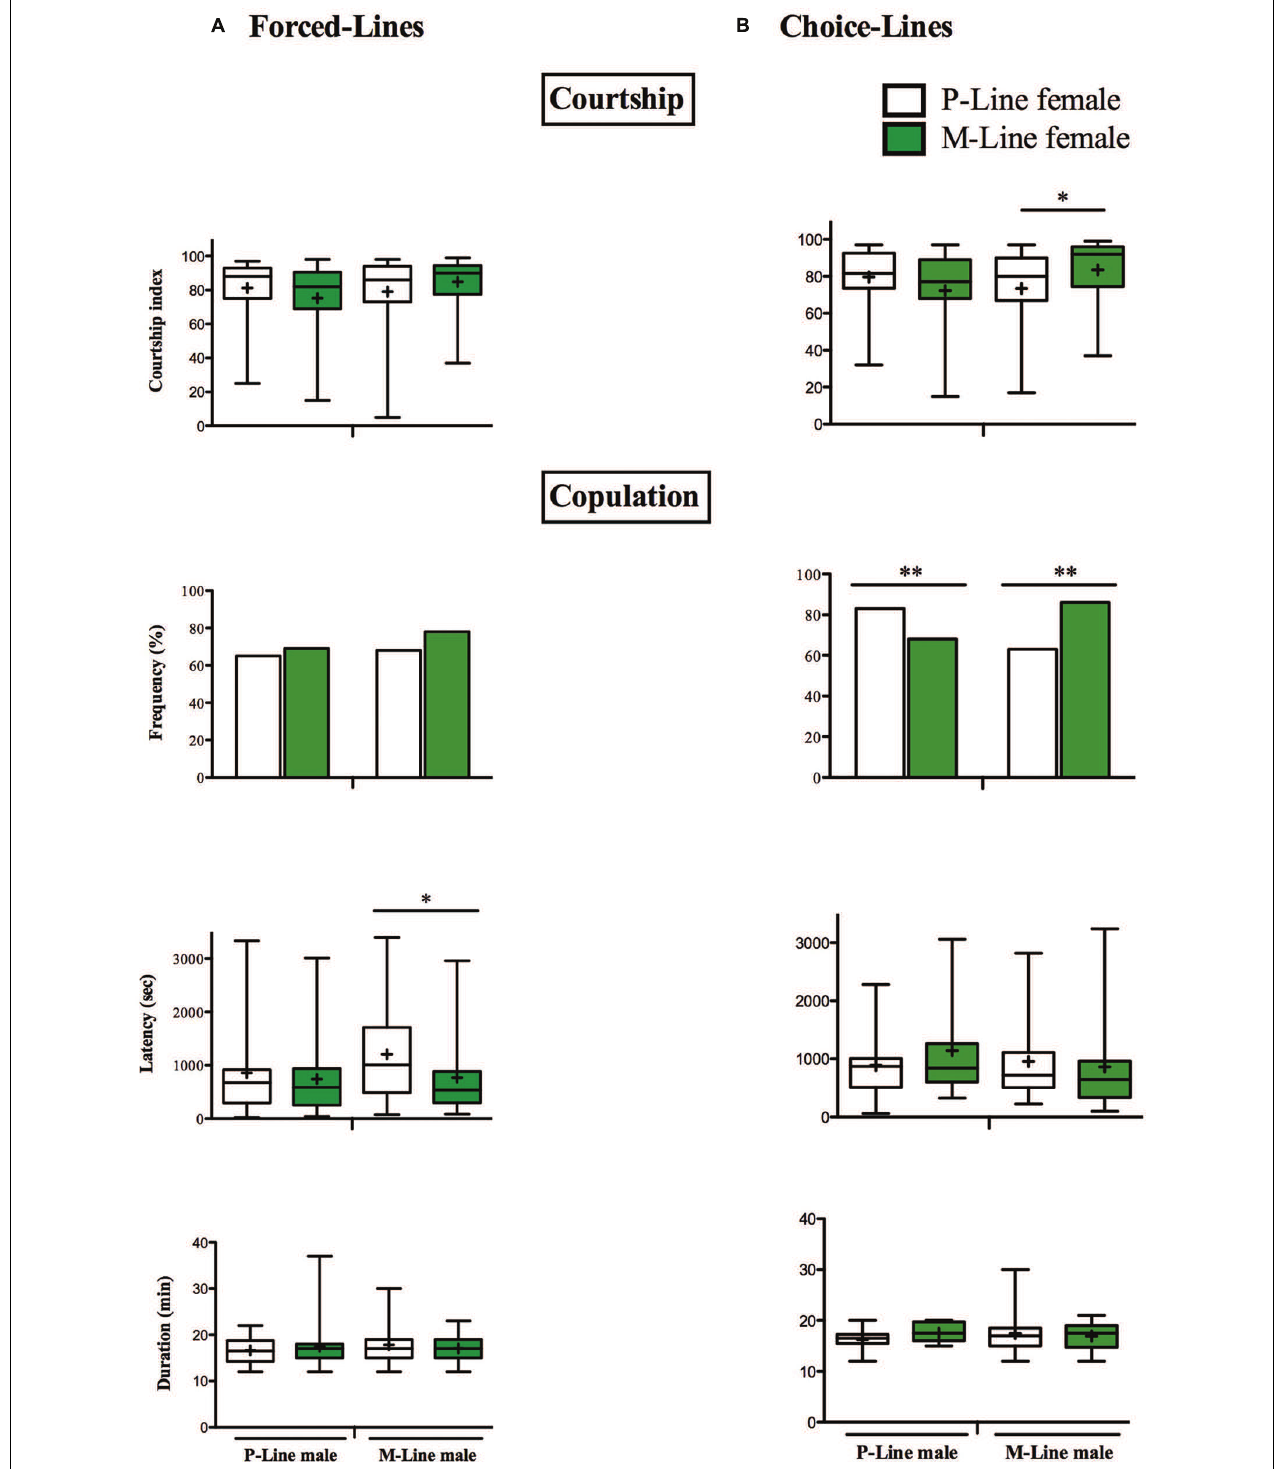
FIGURE 3 | Courtship behavior and mating in two differently exposed lines. Individual 5 day-old males were paired with an intact female of the P-line or the M-line. The box-and-whisker plots show the male courtship index, the latency and the duration of mating. The bar graphs show the frequency of mating. The male courtship index (CI) to the female is measured for 10 min. The frequency of mating, the copulation latency (copulation onset, in sec) and the copulation duration (in min) were measured for 60 min. P-line females: open bars and open boxes, M-line females: green bars and green boxes. (A) Forced-line, (B) Choice-line ( ∗ p < 0.05; ∗∗ p < 0.01). (A) N = 12–17 (B) N = 45–49. For more information, refer to Figure 1